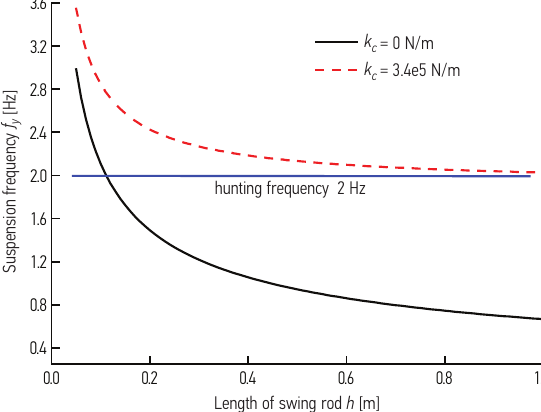
Table 2. The parameters of the drive system Parameters